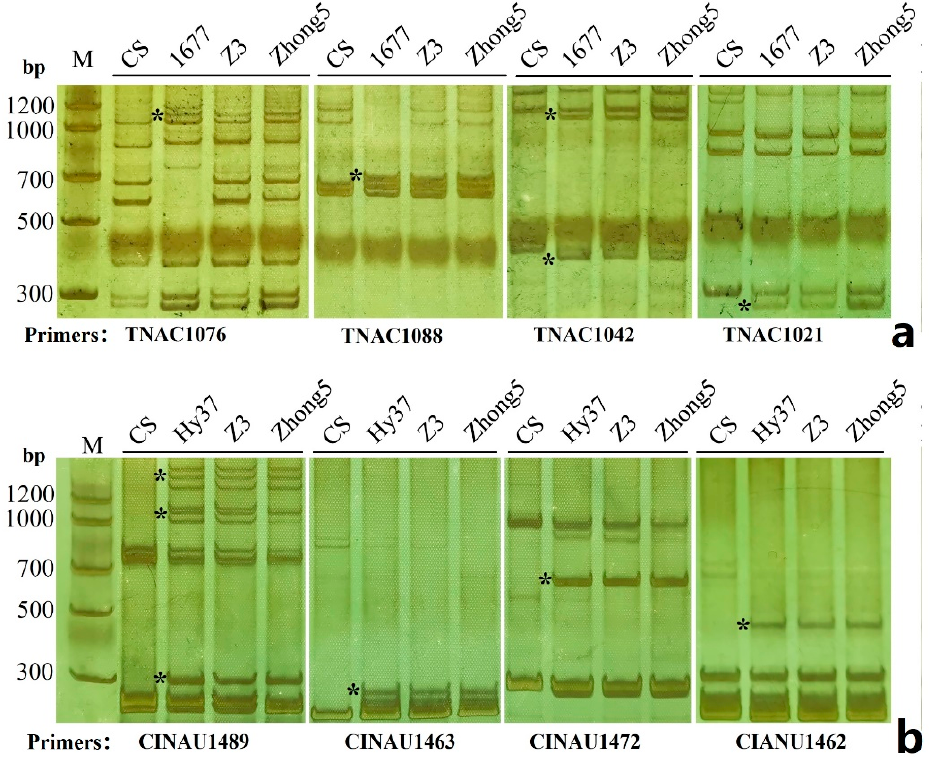
Figure 6. PCR analysis using TNAC and CINAU primers of the short arms of group 1 ( a ) and group 5 ( b ). Materials, CS (Chinese Spring); Hy37 (5JS.3StS translocation line); AS1677 (1St-1D substitution); Z3, Zhong5. The * indicate Th. Intermedium -specific bands.